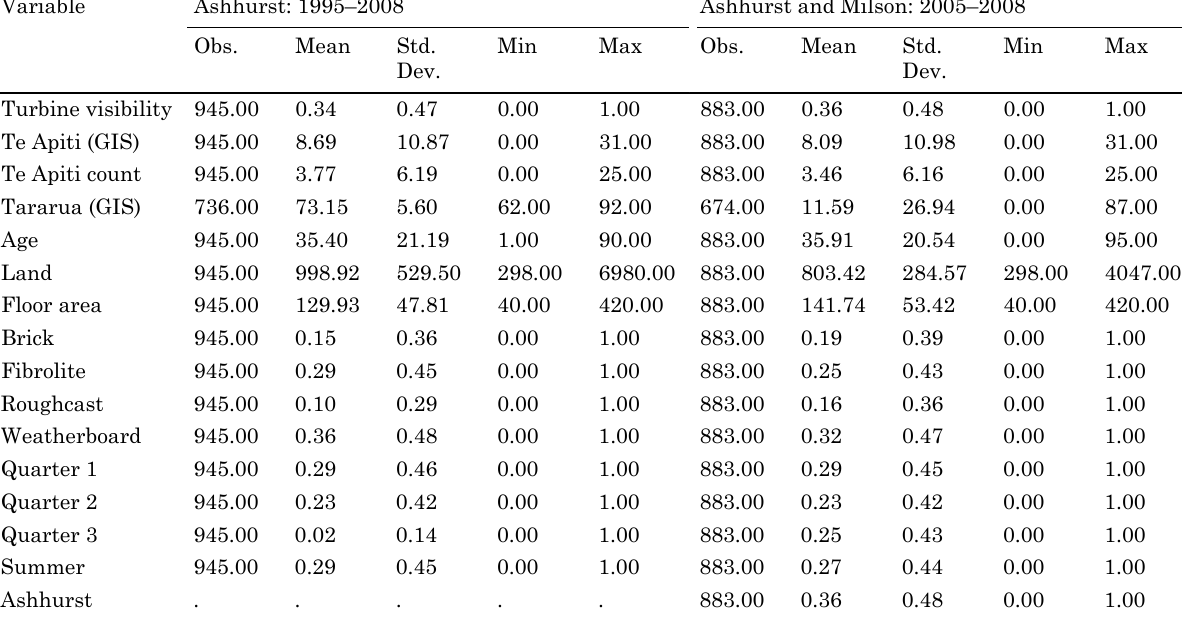
Table 2. Descriptive